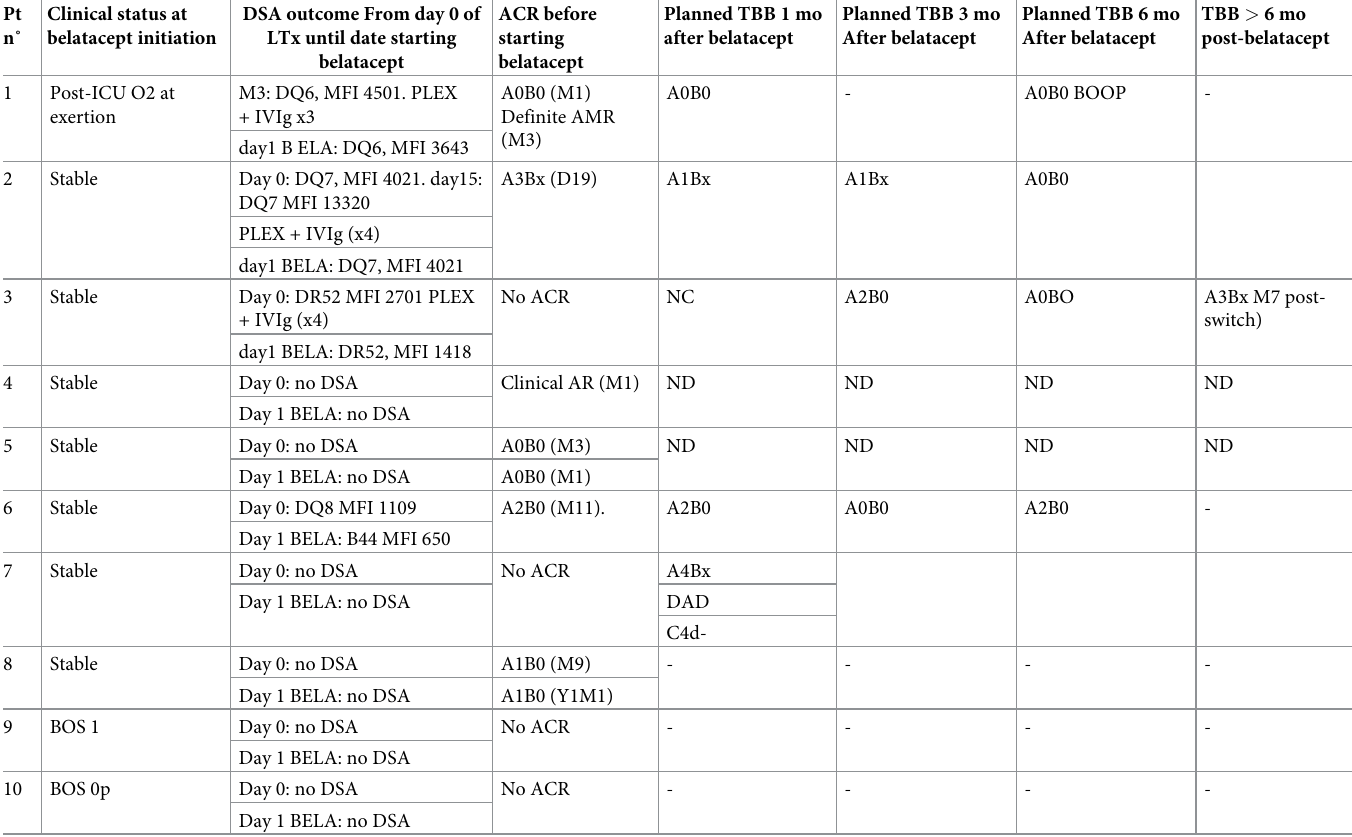
DSA: donor-specific antibody. PLEX: Plasma exchange; IVIg: intravenous immunoglobulins; ACR: acute cellular rejection; BOS: bronchiolitis obliterans